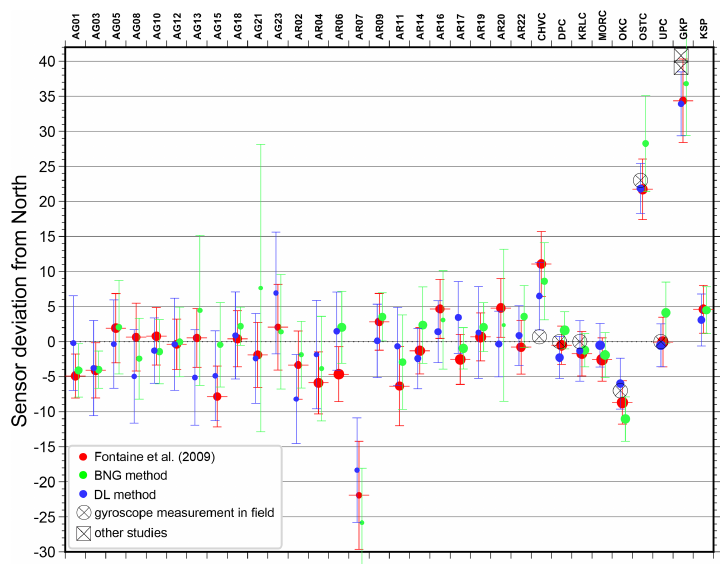
Figure 15. Misorientation angles calculated for all stations using three described methods: red dots – Fontaine et al. (2009) method, green dots – BNG method, blue dots – DL method. Black circles with crosses – orientation angles of permanent stations from direct, high-accuracy measurements in field by gyrocompass (Ludˇek Vecsey, Institute of Geophysics of Czech Academy of Sciences, personal communication, 2020). Black squares with crosses (for GKP station) – orientation angles reported by other studies (Vecsey et al., 2014; Wilde-Piórko et al.,